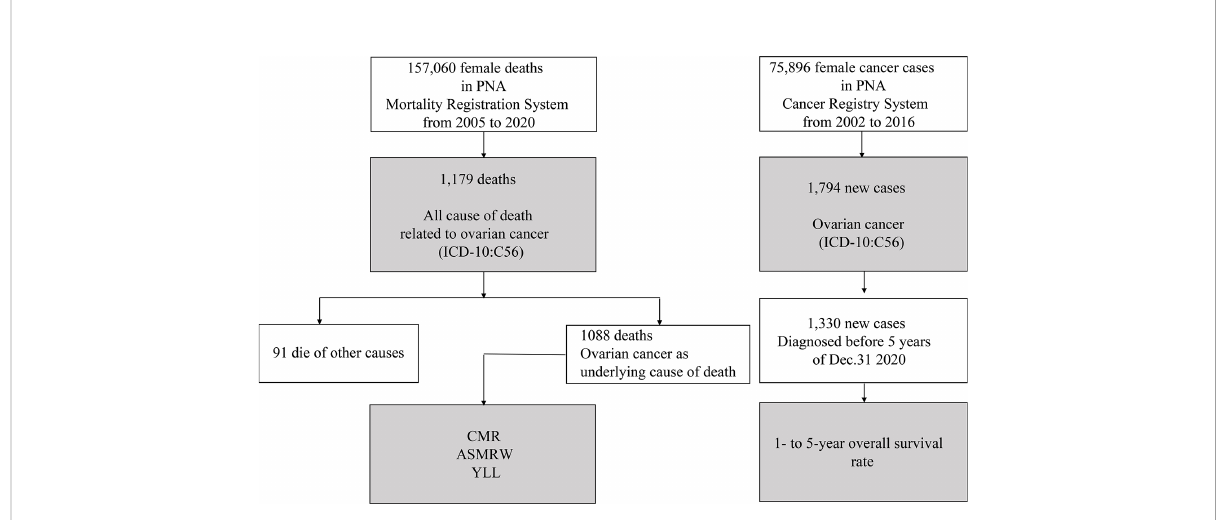
FIGURE 1 Flowchart of data acquisitions and statistical